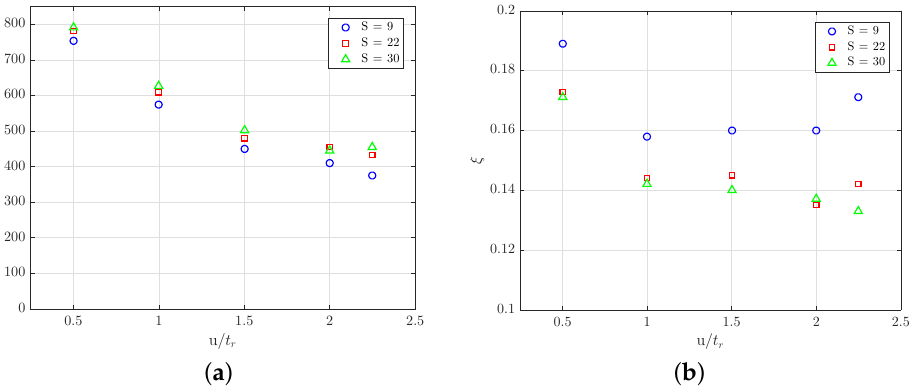
Figure 12. ( a ) Effective horizontal stiffness, k h , and ( b ) equivalent damping ratio, ξ , under different values for the factor